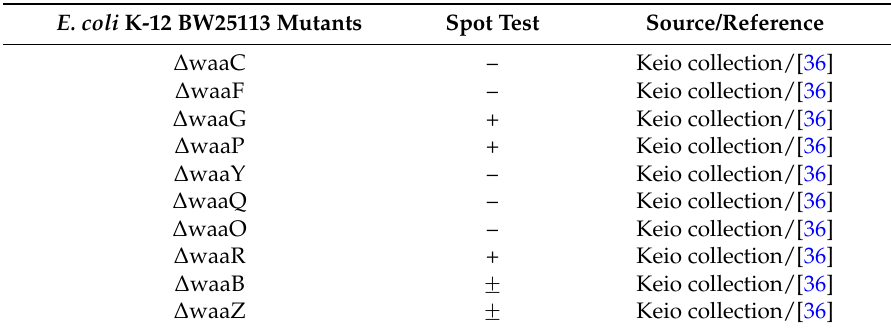
Table 2. Susceptibility of E. coli BW25113 Mutant Strains to VpaE1.